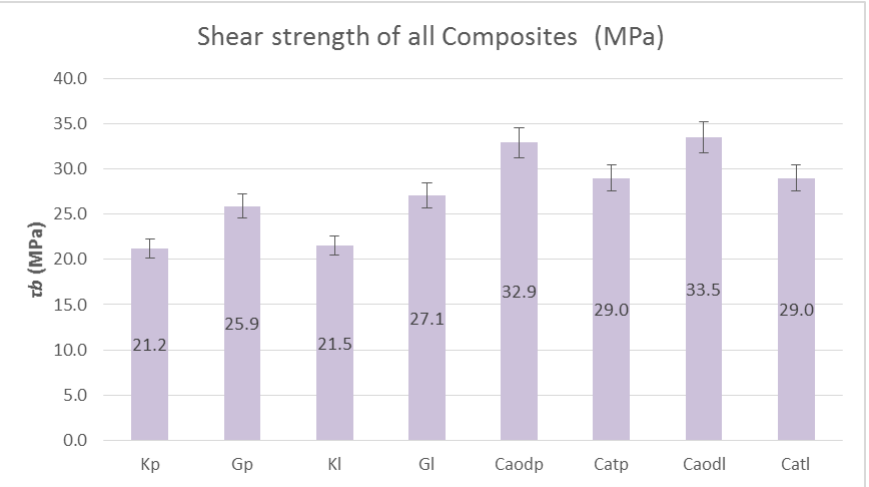
Figure 14. Shear strength of epoxy resin-reinforced specimens (reinforced with carbon fiber, glass fiber and Kevlar fabrics). Variation of values: ±5%.